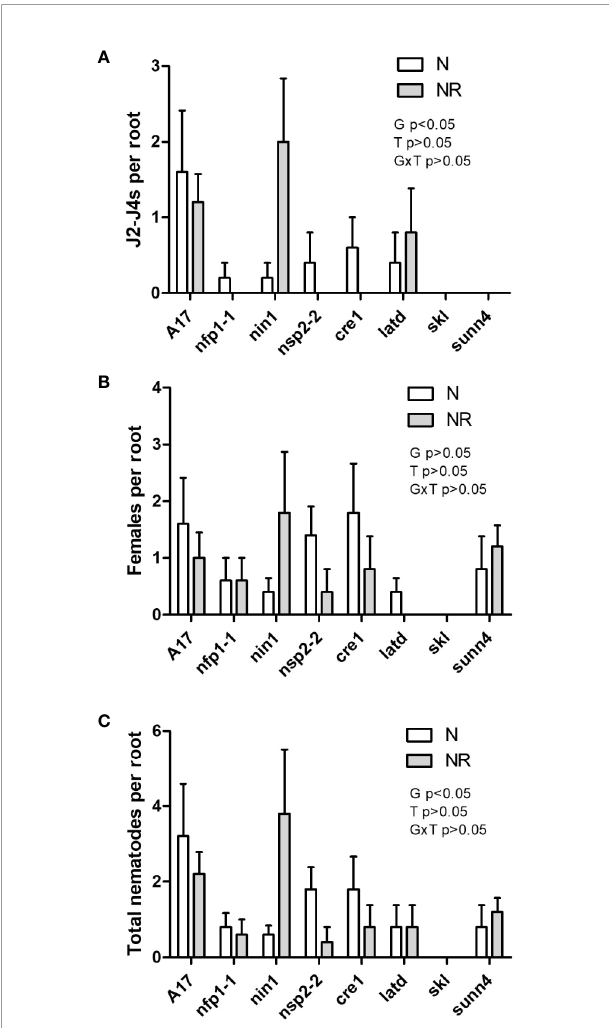
FIGURE 5 | Quanti fi cation of nematodes localized inside M. truncatula roots. Roots were stained with Acid Fuchsin and both juvenile and adult stage M. javanica were counted in each root (examples of these stages are shown in Figure S3 ). (A) Number of J2 to J4 stage nematodes. (B) Number of adult stage nematodes. (C) Total number of juveniles and adults per root. N = 5. Graphs show means and standard errors. Signi fi cant effects of genotype (G), treatment (T), or their interaction (G × T) are shown in each panel but as interactions were not signi fi cant, no pairwise comparisons could be made (two-way ANOVA with Bonferroni